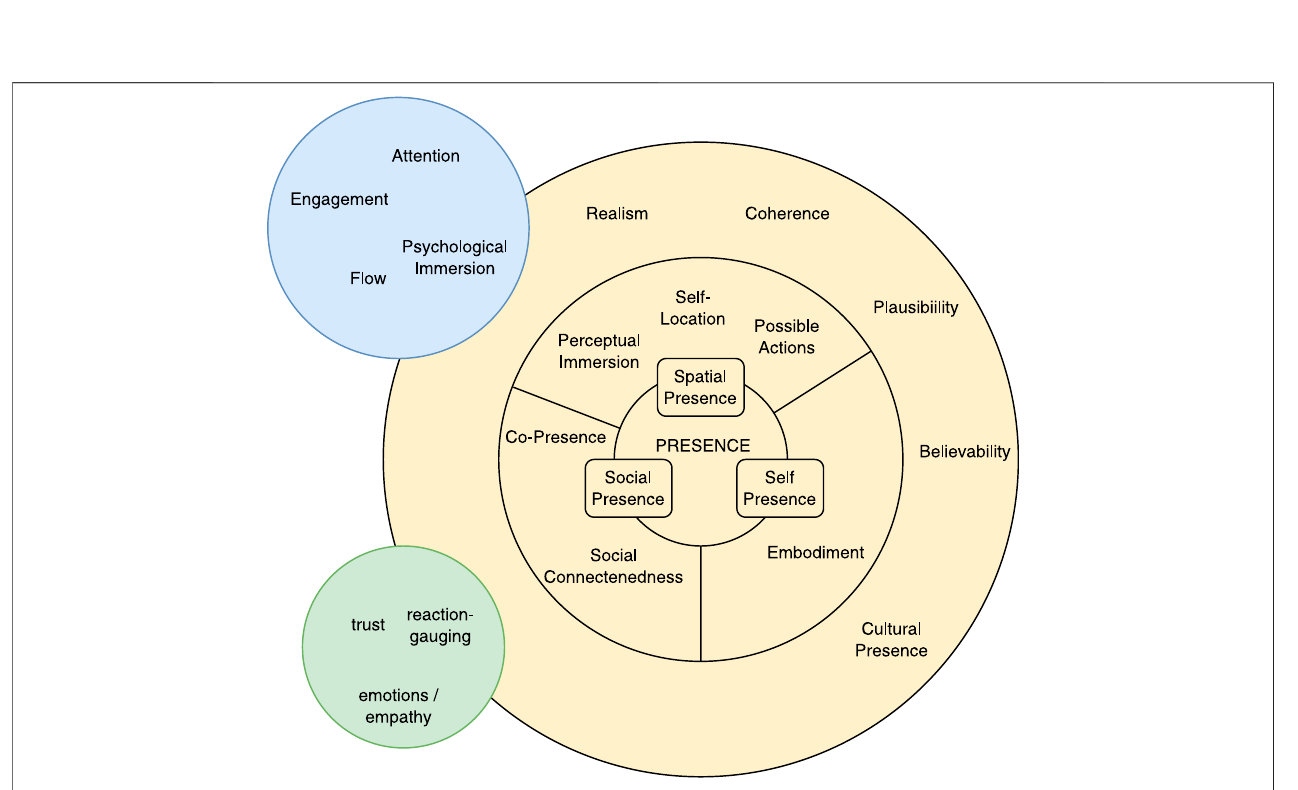
FIGURE 6 | A “ concept map ” of presence dimensions and related high-level QoE features.